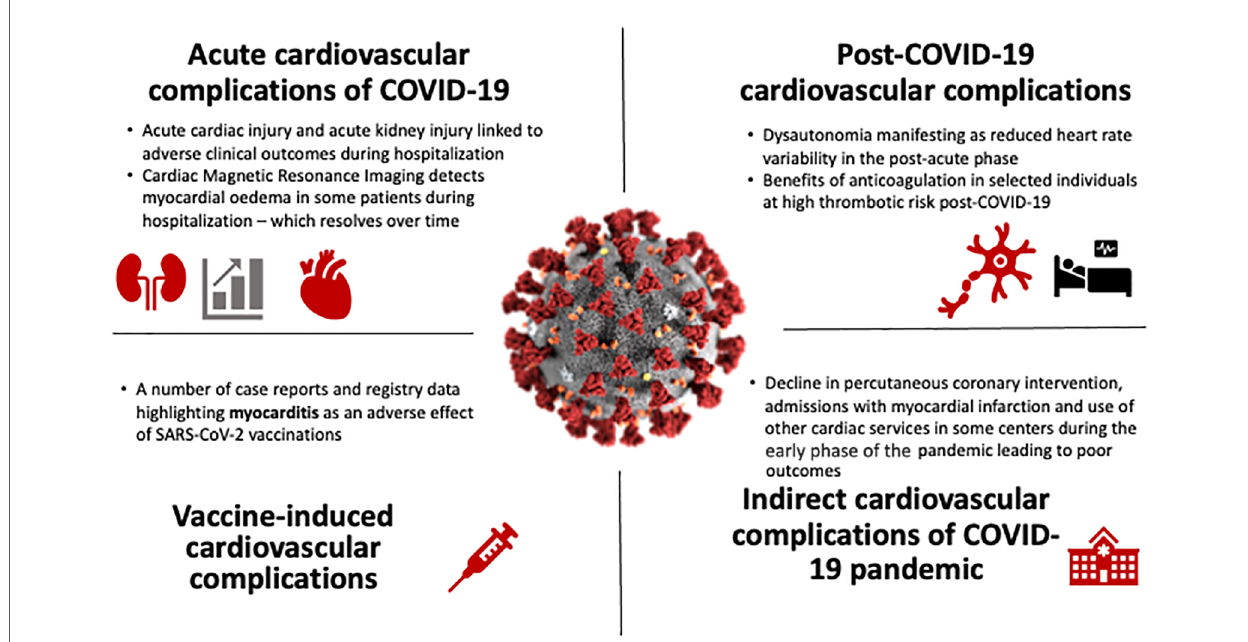
FIGURE 1 Cardiovascular complications of the COVID-19